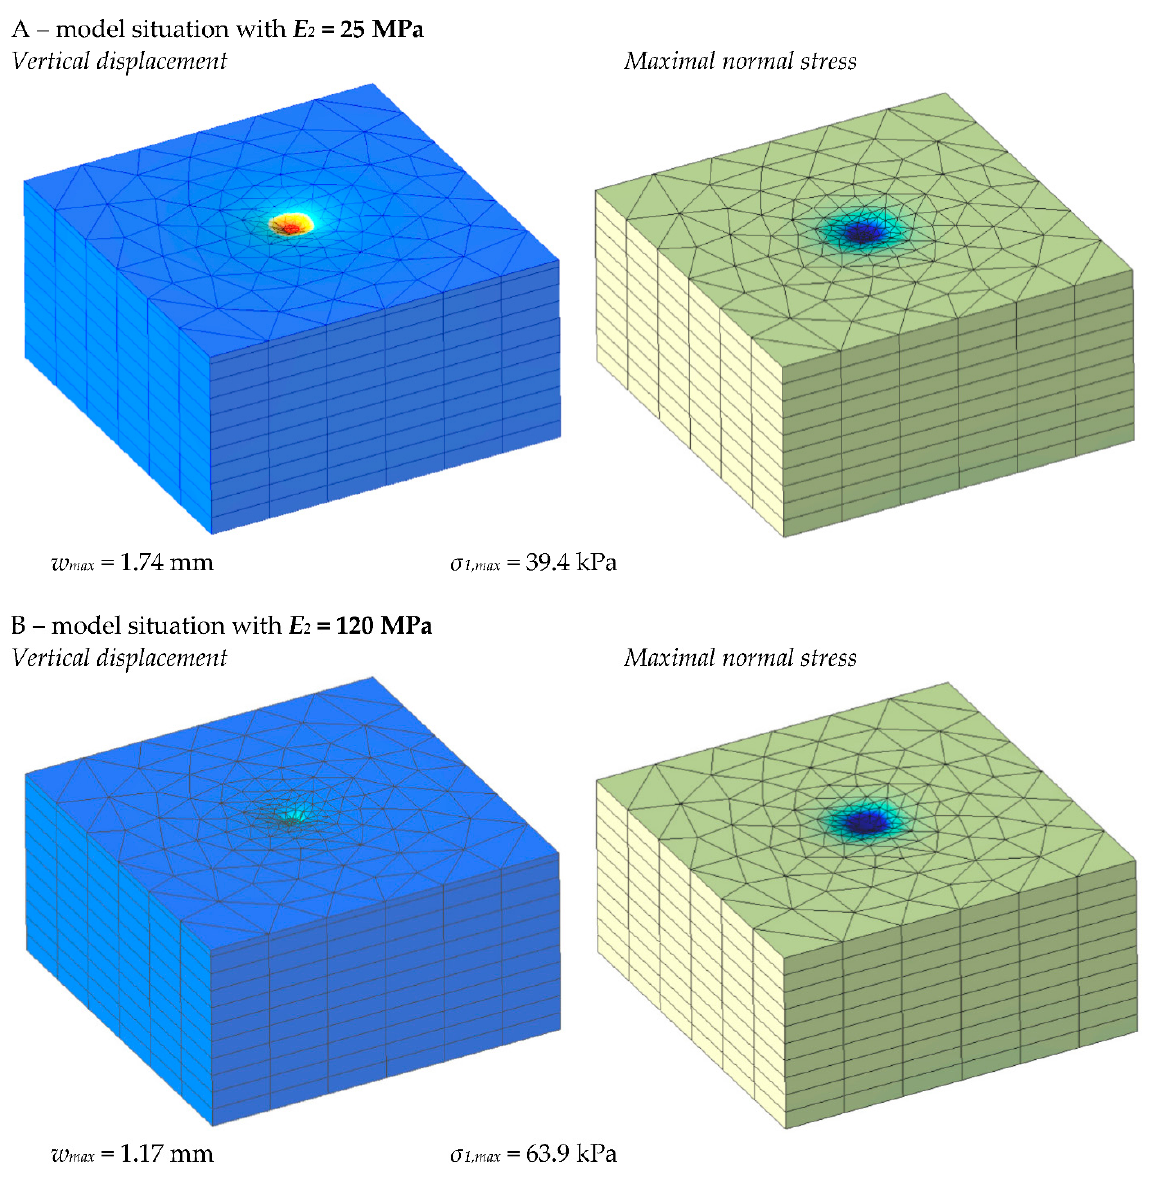
Figure 11. FEM model results for maximal and minimal values E 2.